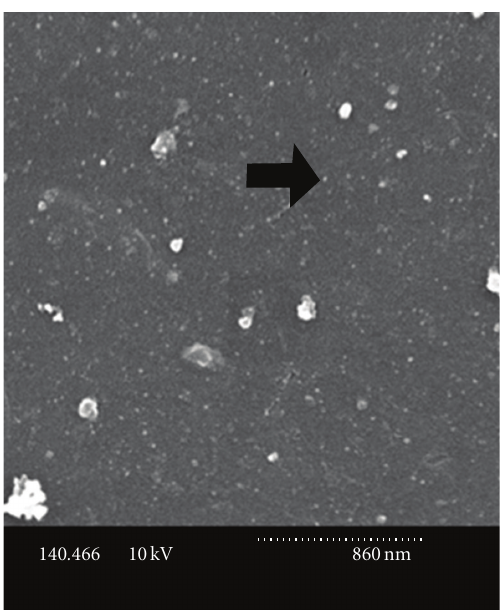
Figure 1: SEM micrograph of typical proteoliposomes. These proteoliposomes were made by high pressure nitrogen filtration, fixed on polished carbon planchettes with OsO 4 , dried, sputter coated with 15nm argon, and viewed using a Hitachi S-570 Scanning Electron Microscope. The dotted scale bar across the bottom represents 860 nm. Arrow indicates typical